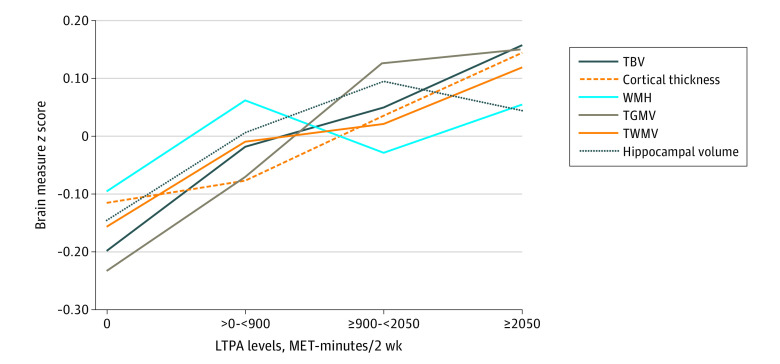
Brain Measures by Leisure Time Physical Activity LevelsBrain measures are standardized (by z scores) for convenient comparisons across different brain measures. Solid lines represent significant associations between leisure time physical activity (LTPA) and brain measures (see trend test in Table 2), while dotted and dashed lines indicate nonsignificant associations. TBV indicates total brain volume; TGMV, total gray matter volume; TWMV, total white matter volume; WMH, white matter hypersensitivity.